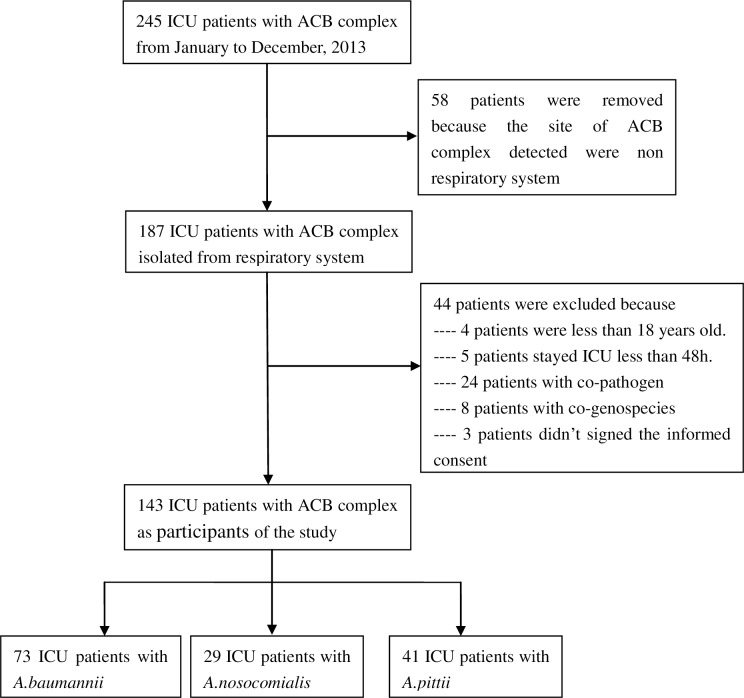
Flowchart of the study enrollment.